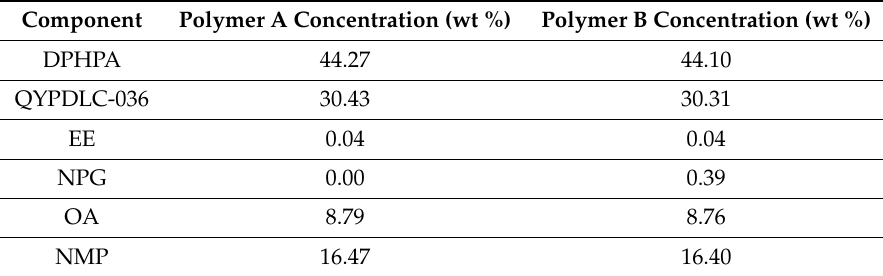
Table 1. Composition for liquid crystal-photopolymer composites.